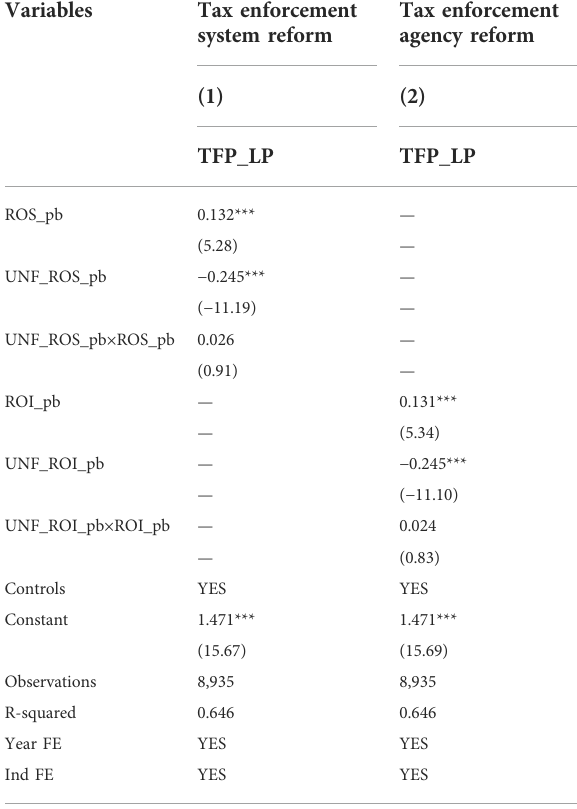
TABLE 7 Regression results for the placebo